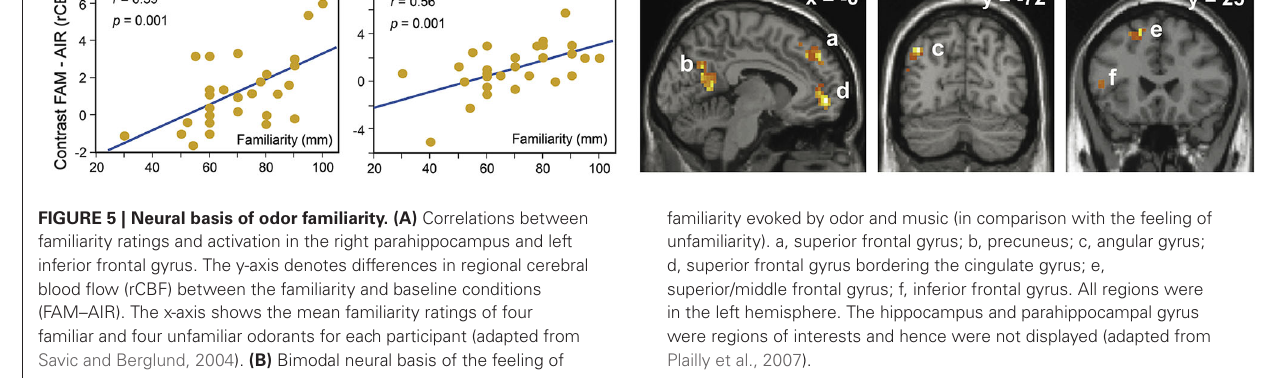
FIGURE 5 | Neural basis of odor familiarity. (A) Correlations between familiarity ratings and activation in the right parahippocampus and left inferior frontal gyrus. The y-axis denotes differences in regional cerebral blood flow (rCBF) between the familiarity and baseline conditions (FAM–AIR). The x-axis shows the mean familiarity ratings of four familiar and four unfamiliar odorants for each participant (adapted from Savic and Berglund, 2004). (B) Bimodal neural basis of the feeling of